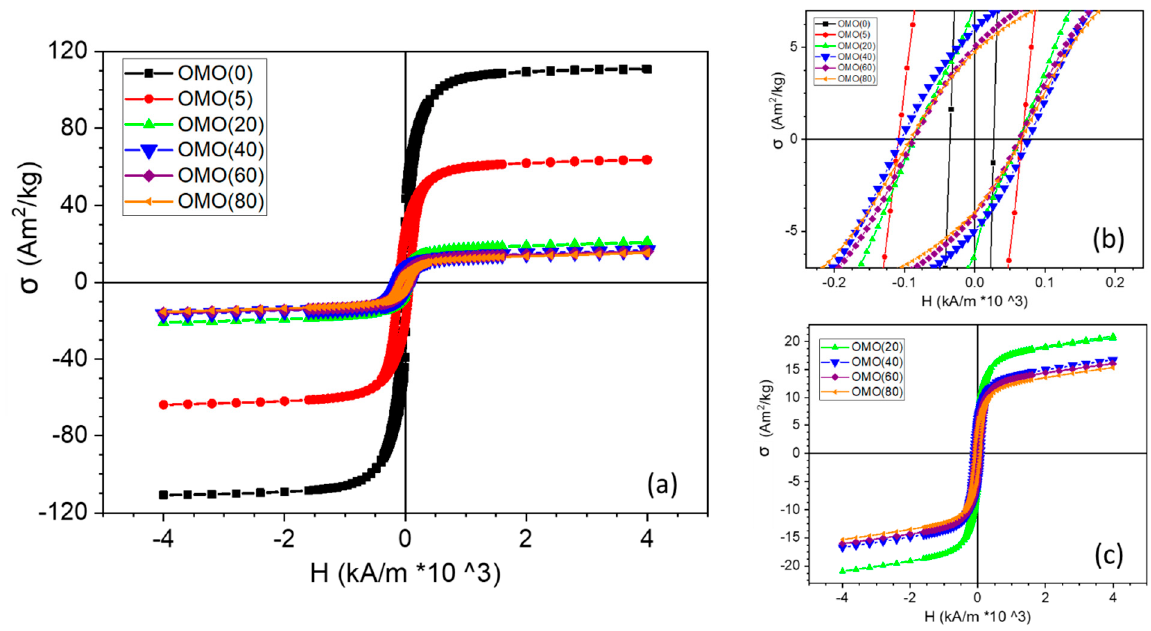
Figure 9. Hysteresis loops of core/shell/shell nanostructures at 5 K after field-cooling (4000 kA/m). ( a ) shows the overall loops, ( b ) is a close-up of the low-field portion of the loops, and ( c ) illustrates the effect of increasing oxidation time on the loops. (Oxidation times in minutes are indicated in the